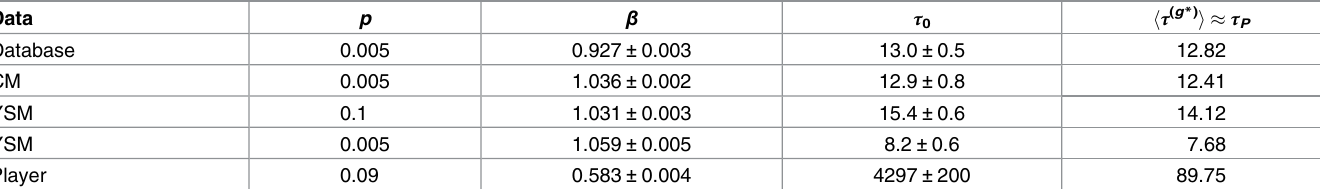
Table 1. Summaryof the results corresponding to the inter-event time distributions of Figs 5 and